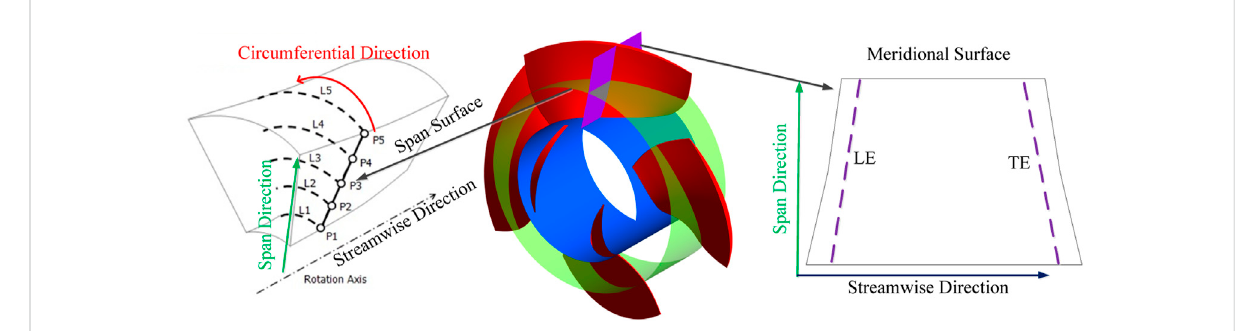
FIGURE 8 The diagram of the weighted average of parameters based on mass fl ow.